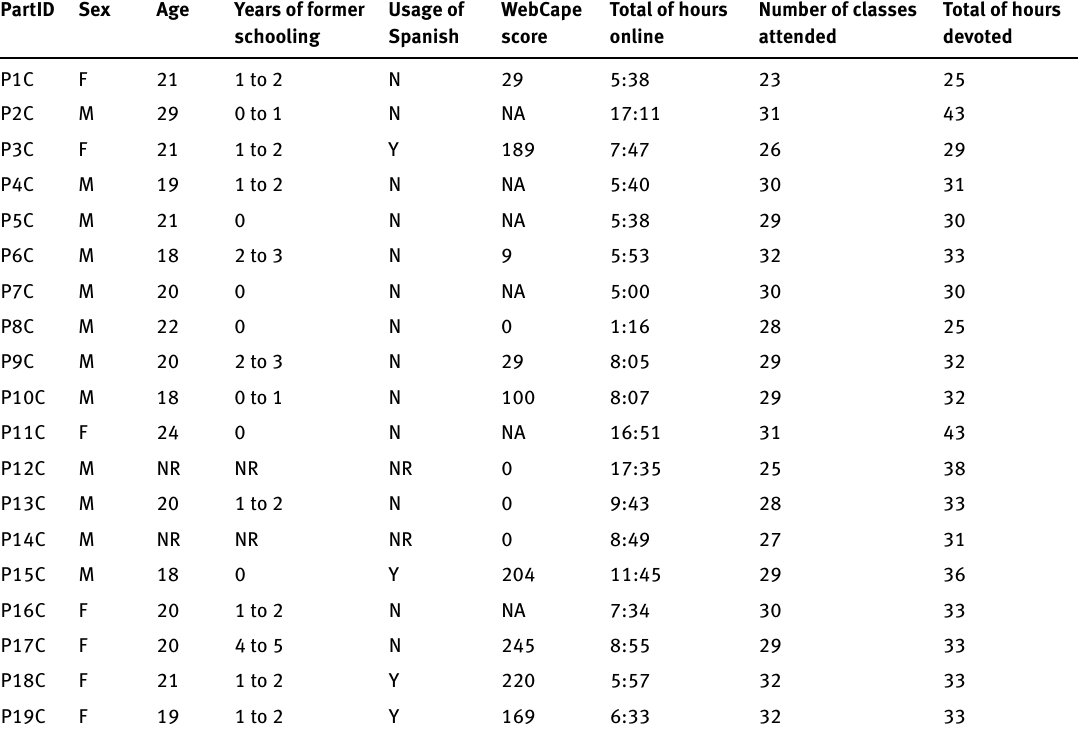
Table 2. Classroom students of Beginning Spanish